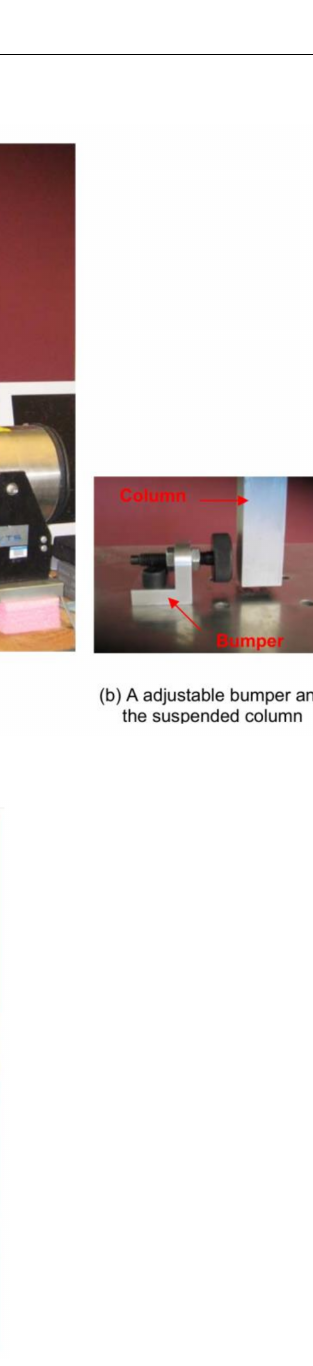
Figure 6. Position of accelerator sensor installed structure.